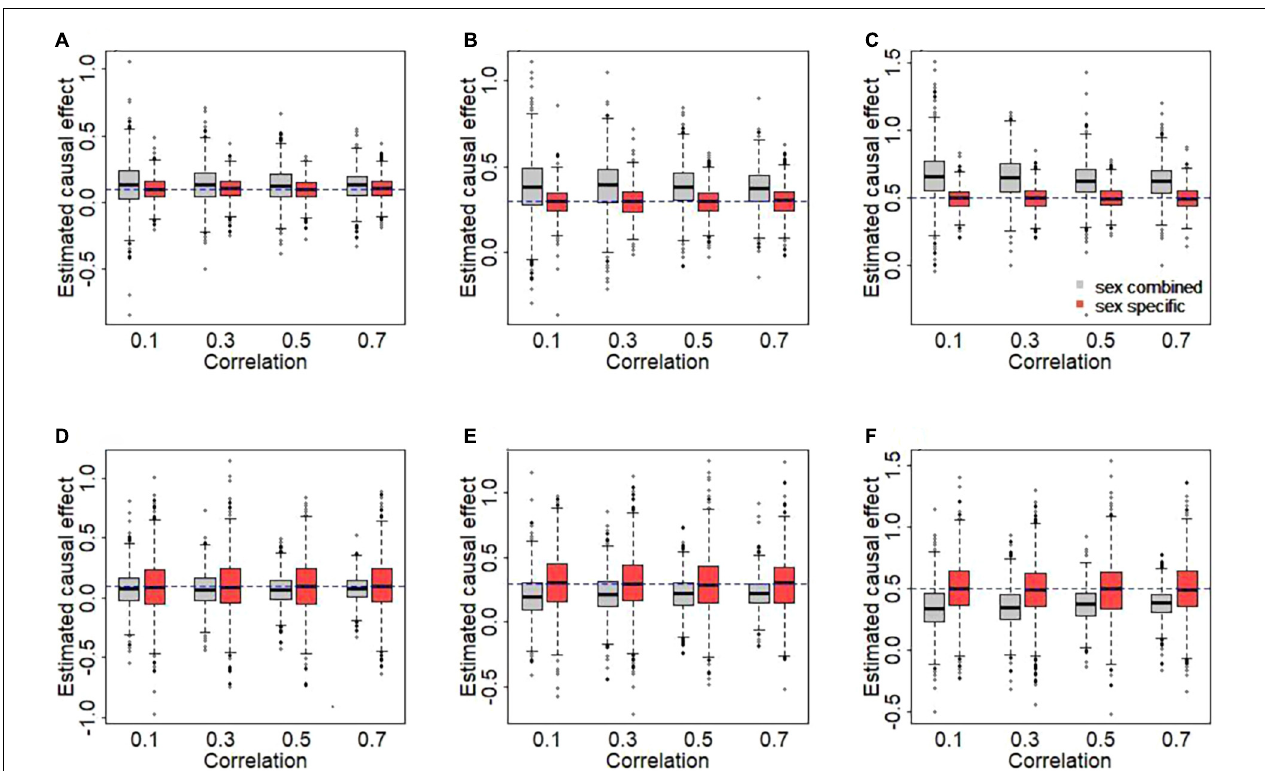
FIGURE 2 | Estimated causal effects with sex-combined or sex-specific instrumental variables in the simulation. (A,D) The true causal effect is 0.1. (B,E) The true causal effect is 0.3. (C,F) The true causal effect is 0.5. In the top panel, the phenotypic variance explained (PVEs) of the male and the female exposures are 1 and 3%, respectively. In the bottom panel, the PVEs of the male and the female exposures are 3 and 1%, respectively.